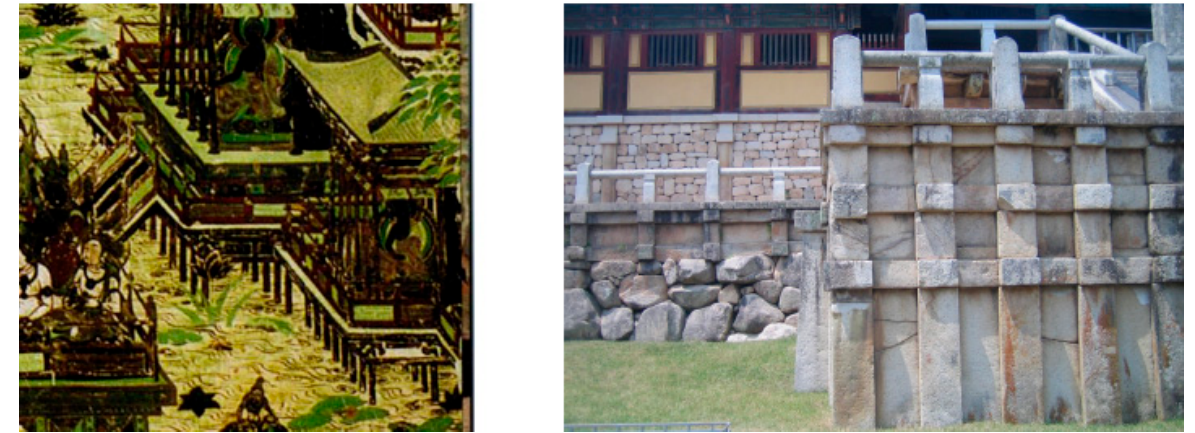
Figure 12. Terraced platforms at Bulguksa Temple and wooden platform with pile construction at Dunhuang Cave 172, the Western Amitabha Paradise, Mid Tang (source: Xiao Mo).